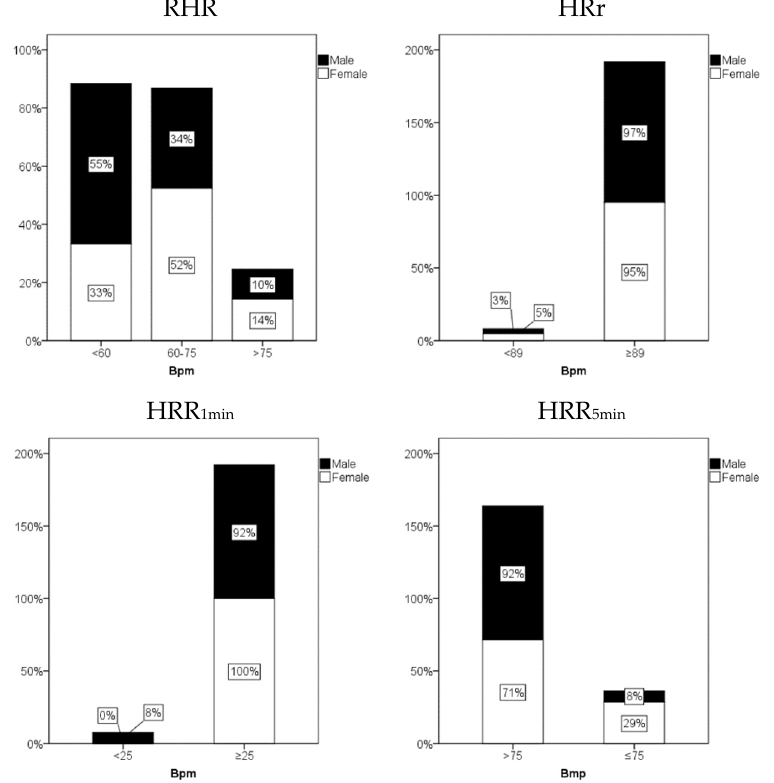
Figure 2. Percentage of athletes within each heart rate (HR) references (at rest, HR reserve and at recovery time) related to a higher risk of death. RHR, resting HR; HRR, HR recovery; HRr, heart rate reserve; Bpm, beats per minute. Table 3. Partial correlations of heart rate parameters with cardiorespiratory fitness and anthropo- metric variables controlled by age and sex.